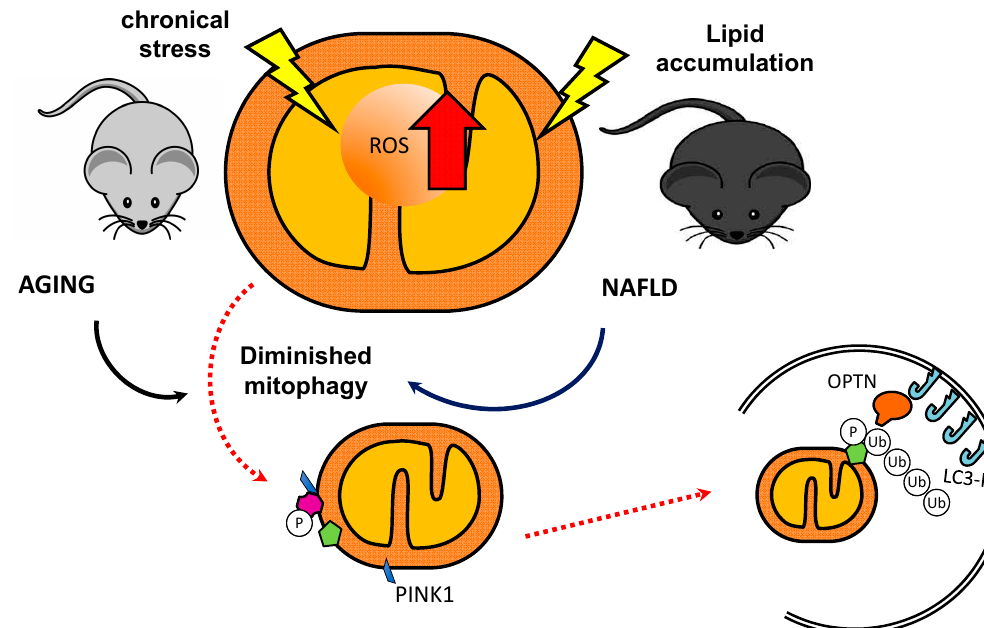
Figure 2. Diminished mitophagy in NAFLD and Sarcopenia. Mitophagy-associated proteins are decreased during the aging process and have been linked with aging associated diseases. The accumulation of damaged mitochondria because of impaired mitophagy could be involved in the development of disease and organ